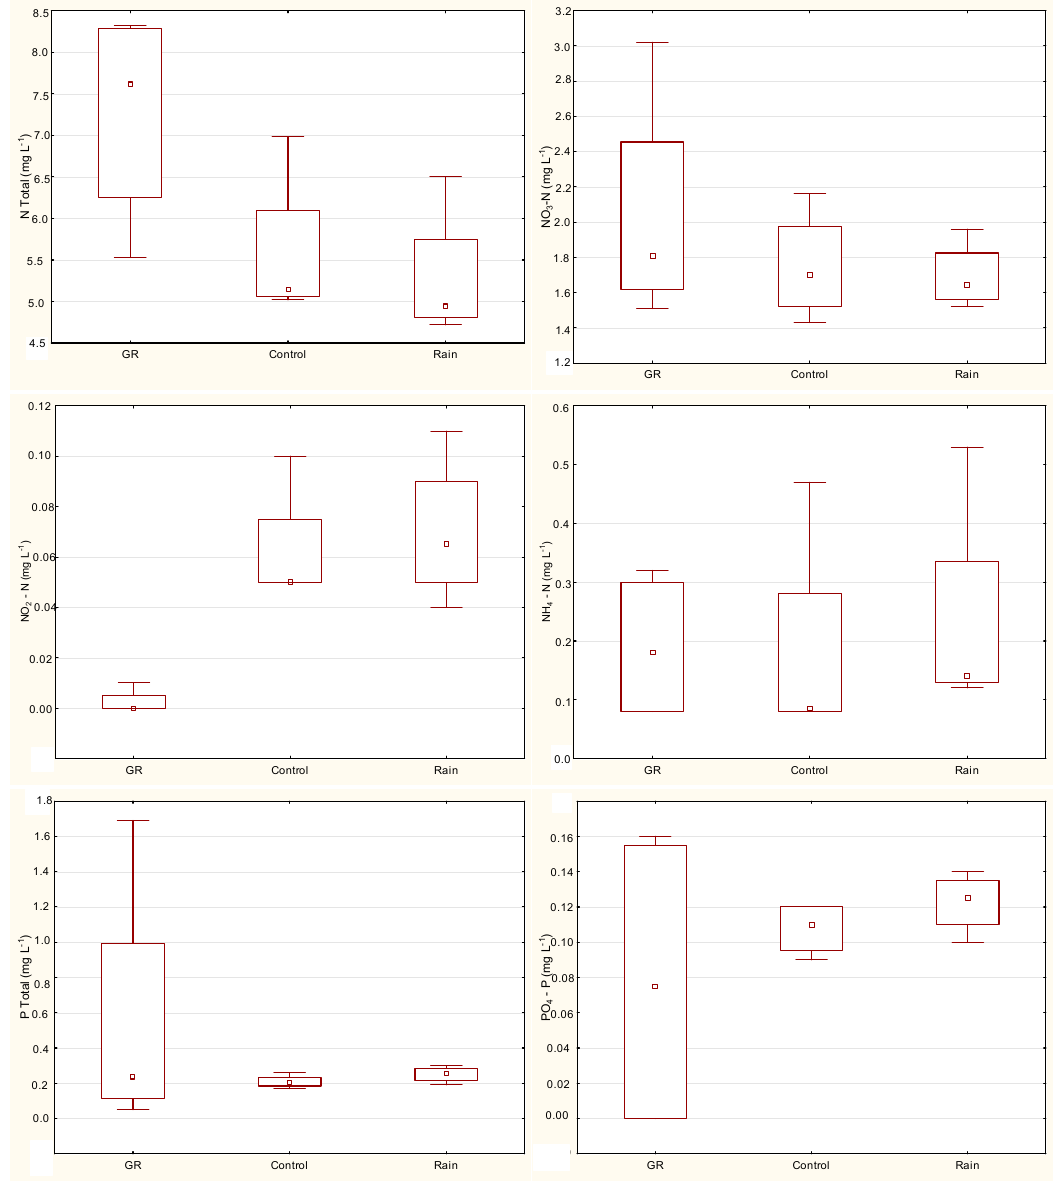
Figure 7. Ranges and mean values of contamination indicators in runoff waters for experimental area surface GR1 and GR2.